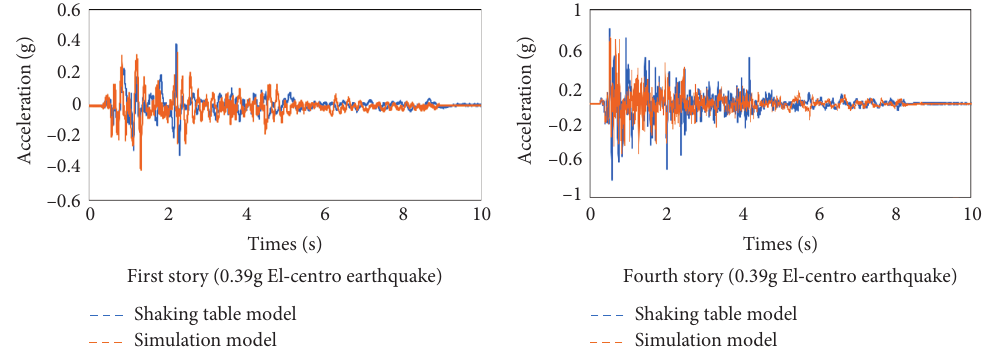
Figure 45: Comparison of acceleration time-history response between numerical model and shaking table model.